Question: Briefly state, in one sentence, what is plotted here.
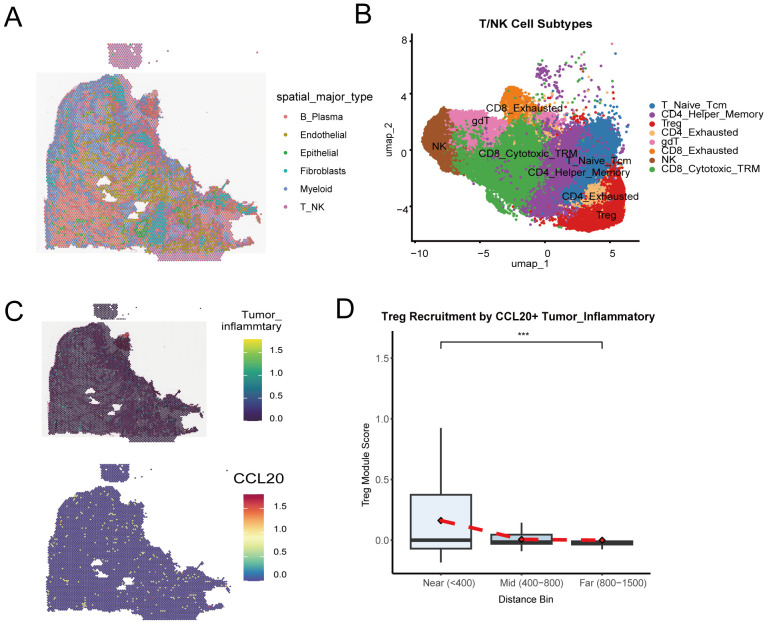
Answer: Spatial validation of the cellular architecture and the treg recruitment hypothesis. (A) Spatial transcriptomics atlas of a lung adenocarcinoma tissue section, depicting the spatial distribution of major cell types (epithelial, fibroblast, myeloid, T/NK cells). (B) UMAP re-clustering of T/NK cells, detailing lymphocyte subsets including Tregs and exhausted T cells. (C) Comparative spatial heatmaps of the inflammatory tumor signature score (top) and the Treg infiltration score (bottom). Brighter colors (yellow/green) indicate higher scores, visually demonstrating their substantial spatial overlap (co-localization). (D) Box plot of Treg enrichment analysis based on spatial distance. The x-axis represents distance intervals from the “inflammatory tumor region” (Near: <400 µm; Medium: 400-800µm; Far: 800-1500µm), and the y-axis shows the Treg module score. Results indicate a significant enrichment of Tregs in the near-distance region. ***, P < 0.001.